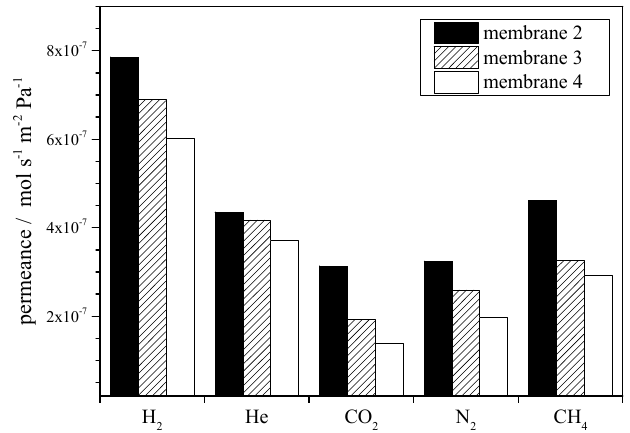
Figure 6. Comparison of single gas permeance of small gases for the differently prepared membranes (2.2, 3.2 to 4.2 with increasing numbers of seeding steps 1, 2 to 3 numbers, respectively (see Table 1).